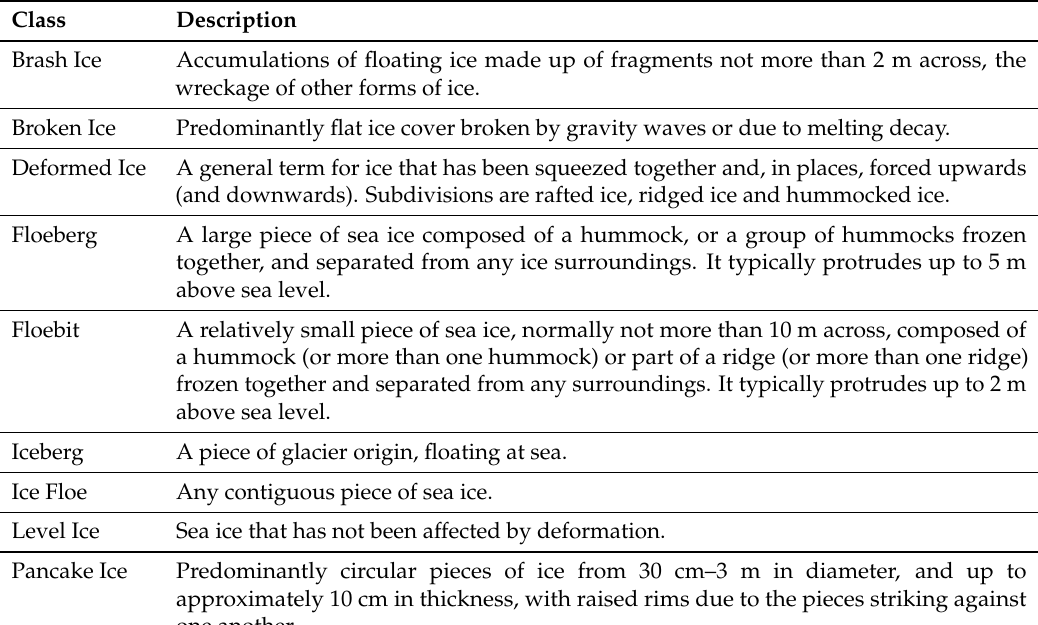
Table 1. The definition of ice classes used in this